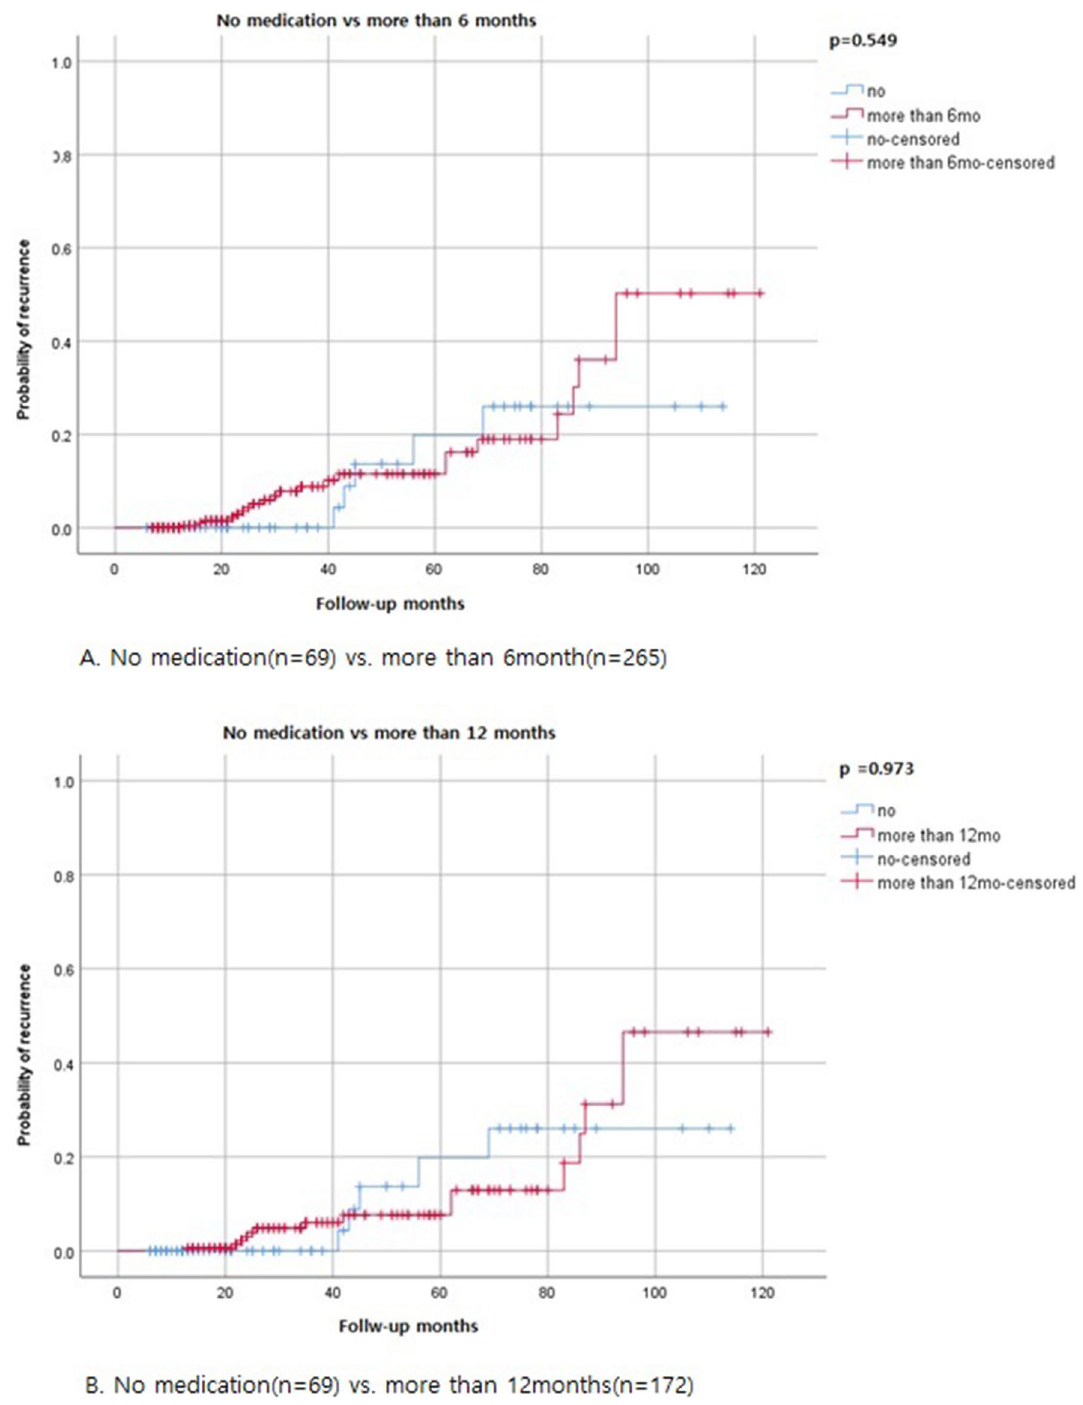
Figure 4. Subgroup analysis of recurrence rates in no medication vs duration of medications. (Log-rank